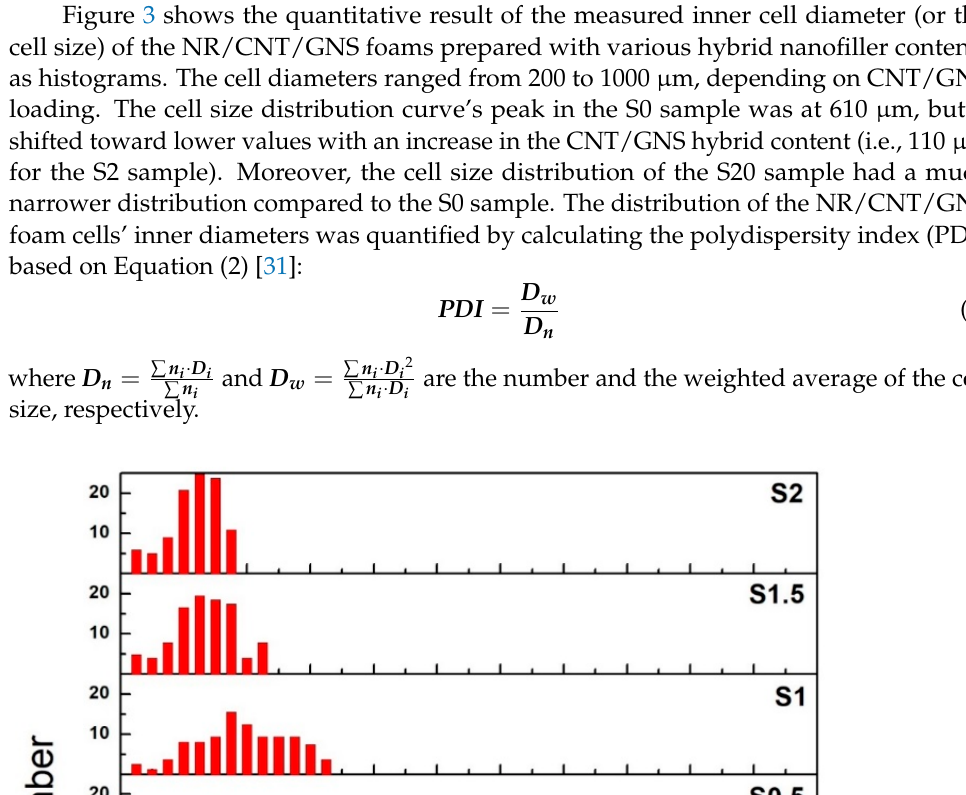
6 of 16 Figure 2. Cell morphology of NR/CNT/GNS nanocomposite foams with different CNT/GNS hy-